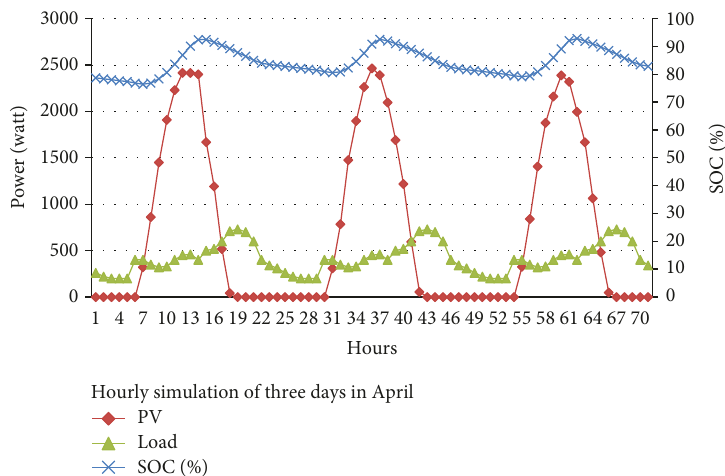
Figure 10: Hourly simulation of load power, PV power, and the battery SOC in three days in April.